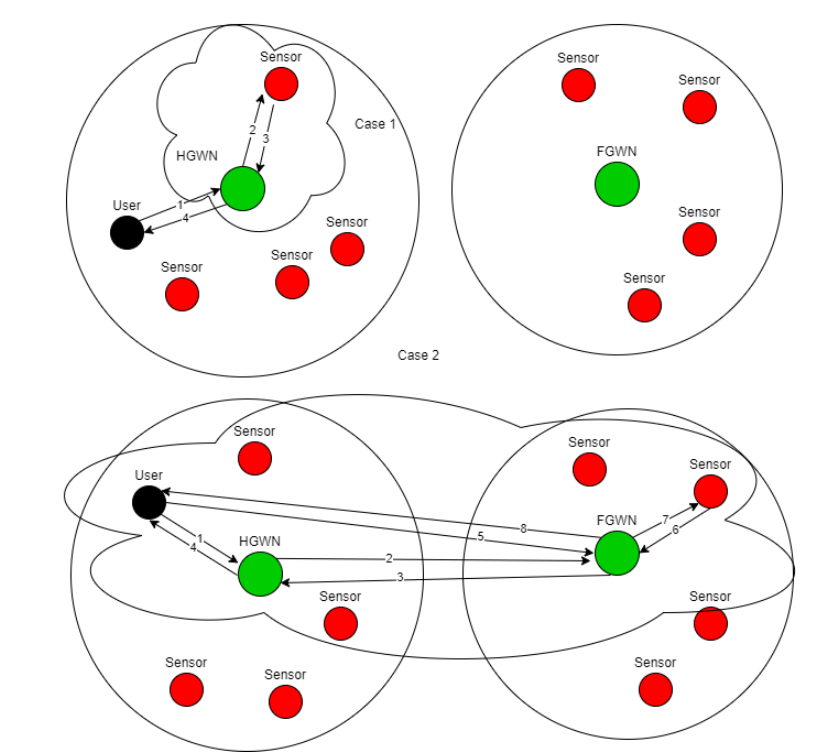
Figure 4. Multi-gateway communication